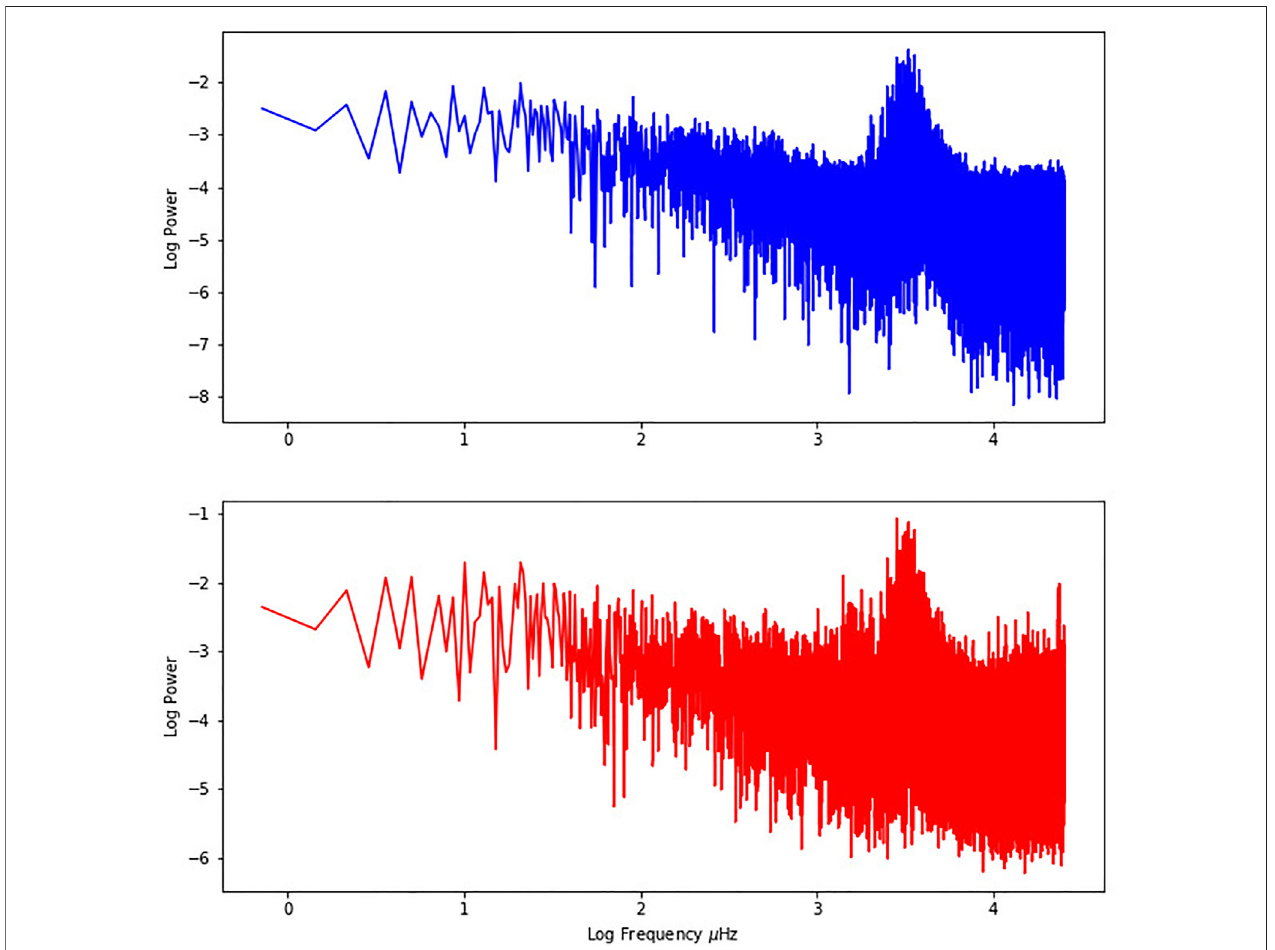
FIGURE 3 | Modi fi ed (red) and Classical (blue) Fourier Transforms of the SoHO data obtained during 16 days, from 0 to the Nyquist frequency (i.e., 25 mHz) in loglog scale.